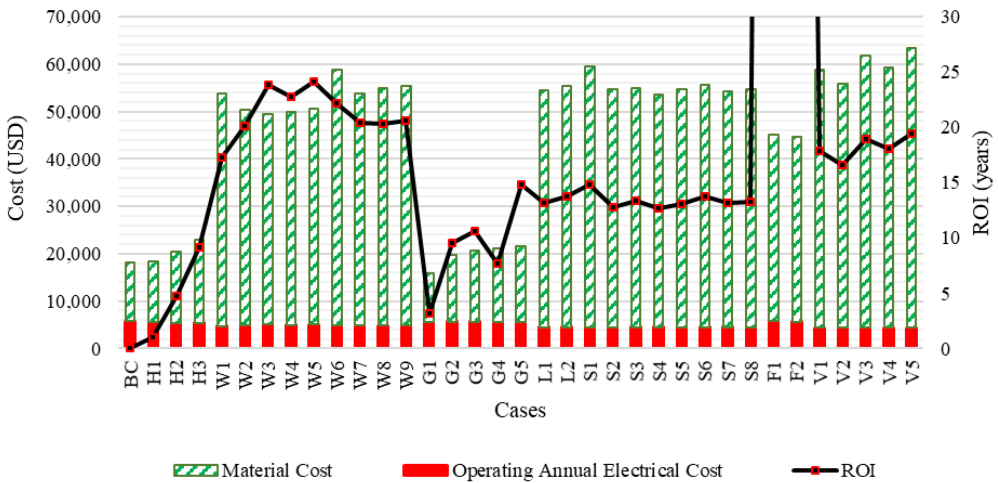
Figure 4. The initial (material) cost, operating costs, and ROI. Buildings 2018 , 8 , x FOR PEER REVIEW